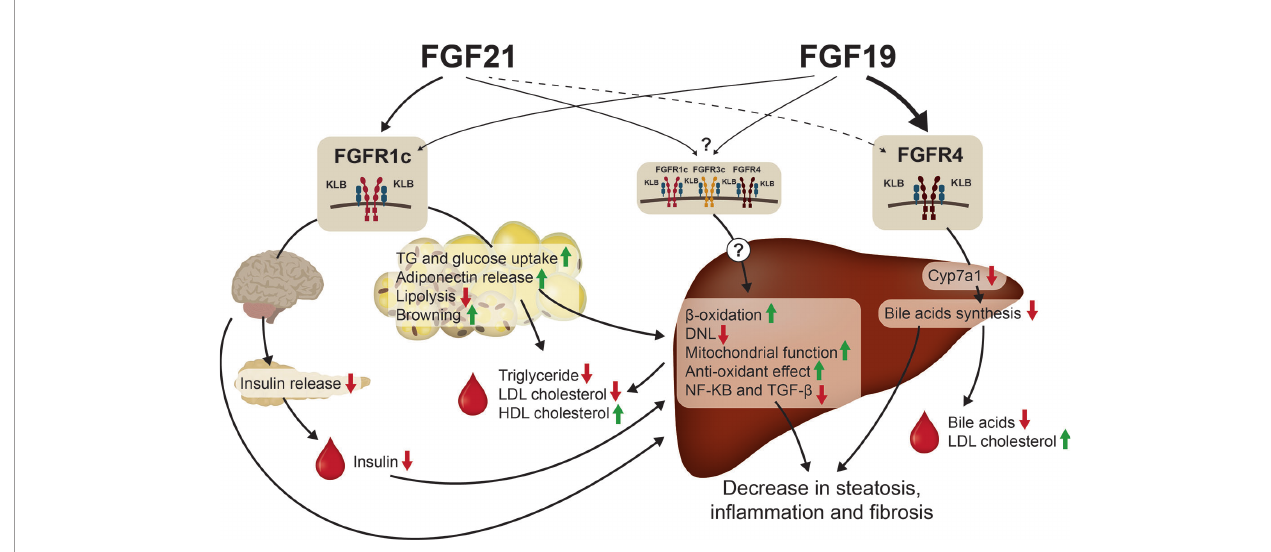
FIGURE 3 | FGF19 and FGF21 treatment of NASH. The effect on hepatic steatosis, in fl ammation and fi brosis seem to be mediated via activation of the FGFR1c/ KLB complex in the CNS and in the adipose tissue. FGF21 has been shown to decrease insulin release which will increase hepatic beta-oxidation and decrease DNL. FGF21 is furthermore a strong inducer of adiponectin release which has been shown to have several bene fi cial effects on NASH. FGF21 also increases the antioxidant capacity of the liver and increase the mitochondrial function. In addition, FGF21 lowers plasma TG, LDLc, and increases plasma HDLc. FGF19 has also been shown to activate the FGFR1c/KLB pathway but in addition FGF19 decreases bile acids synthesis via FGFR4/KLB activation, which has bene fi cial effect on NASH. It is unknown, if FGF21 activates the FGFR4/KLB complex and if other FGFRs (FGFR2c and FGFR3c) expressed in liver are involved in direct action of FGF19 or FGF21.